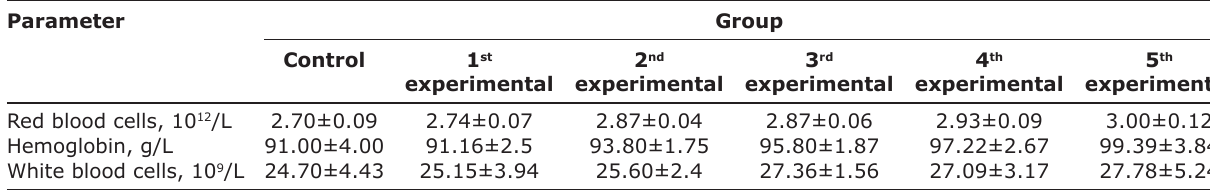
Table-1: Morphological parameters of the blood of broiler chickens. Parameter